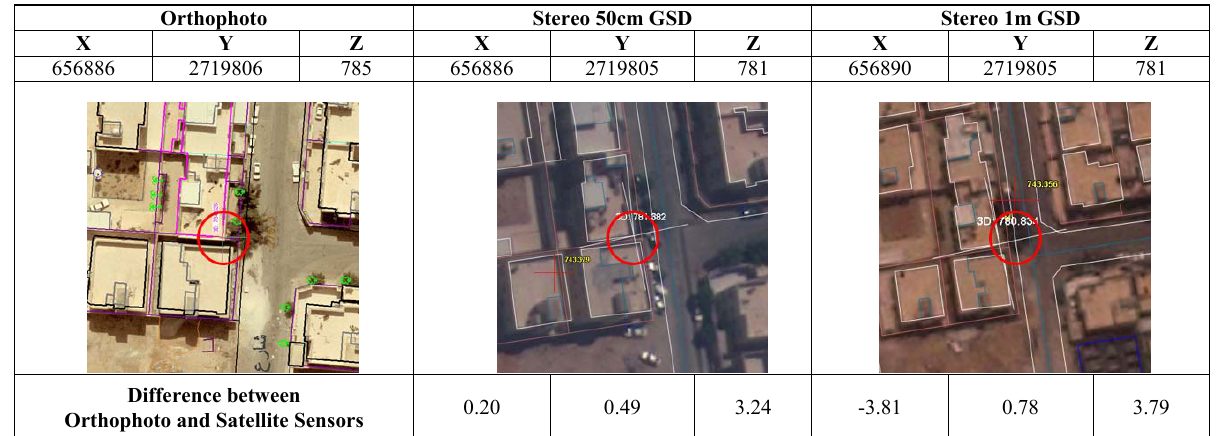
Table 1d. showing comparability between Orthophoto and Satellite imagery adjacent to tree